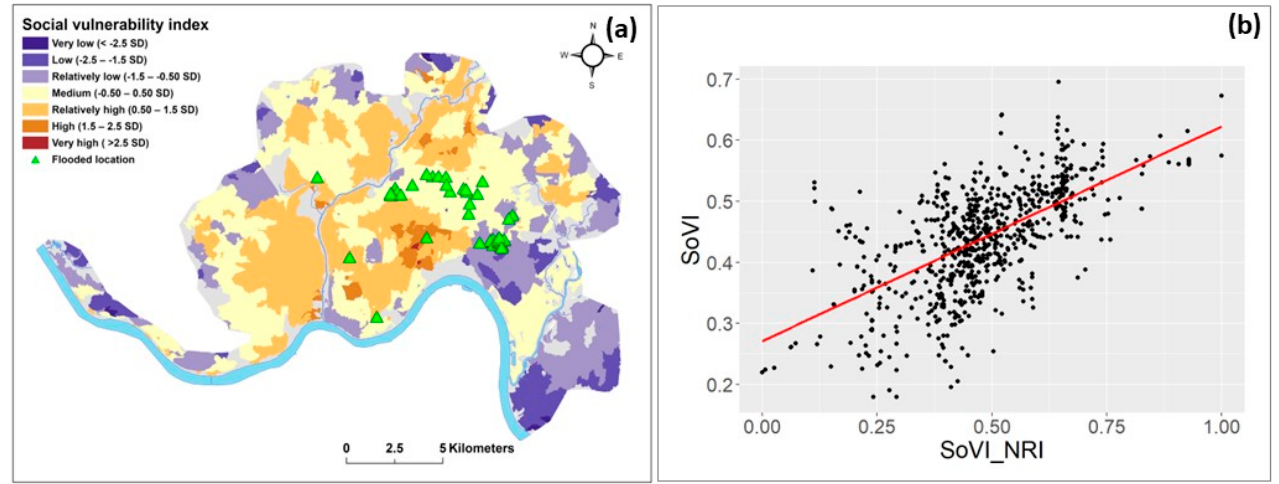
Figure 6. The results of individual social vulnerability indicators, ( a ) % households below poverty level, ( b ) % households with one or more people 60 years old and over, ( c ) % households with income lower than $100,000, ( d ) % female population, ( e ) % population living alone, ( f ) % renter occupied units, ( g ) % buildings before 1939 or earlier.